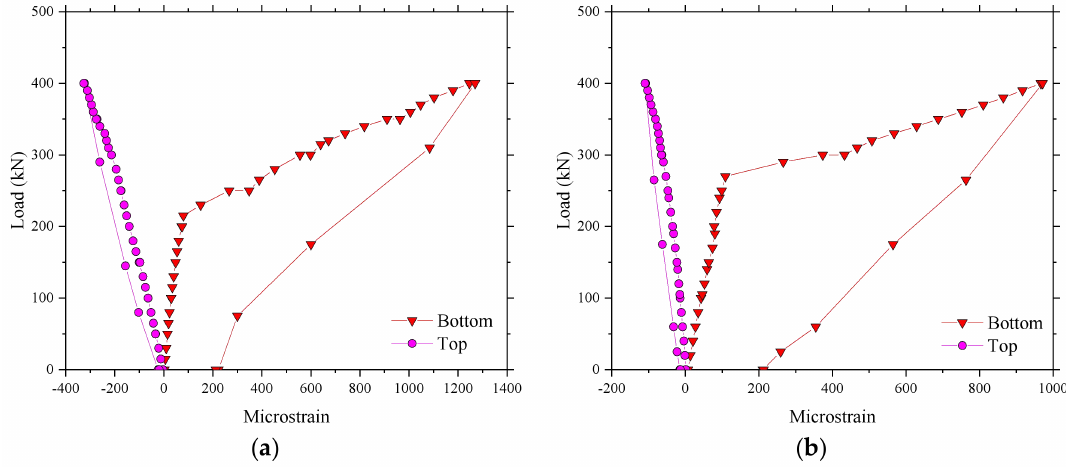
Figure 9. Microstrain in the test areas. ( a ) Microstrain for the test region 2; ( b ) Microstrain for the test region